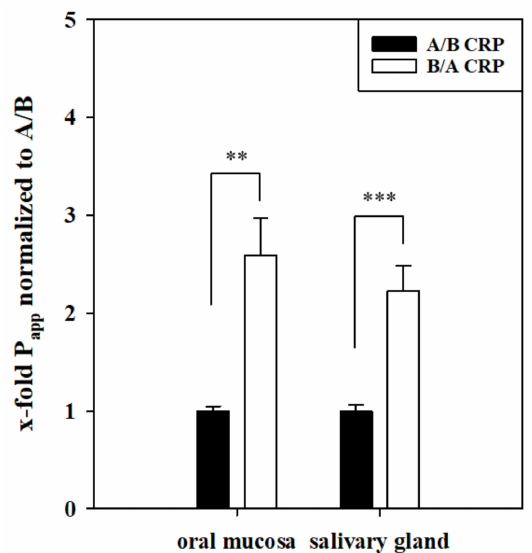
Figure 2. Apparent permeability (P app ) of 10 µ g/mL CRP applied on the apical (A/B) or basolateral (B/A) side for 24 h in the oral mucosa model, based on TR146 cells, and salivary gland model, based on clone B2 of HTB-41 cells. Results calculated as x-fold referred to P app A/B, shown as mean ± SEM after referring to P app values for A/B of each individual experiment of in total three independent experiments (N = 11–13). Statistical analysis was performed as Student’s t -test with α = 0.05, p < 0.01 **, p < 0.001